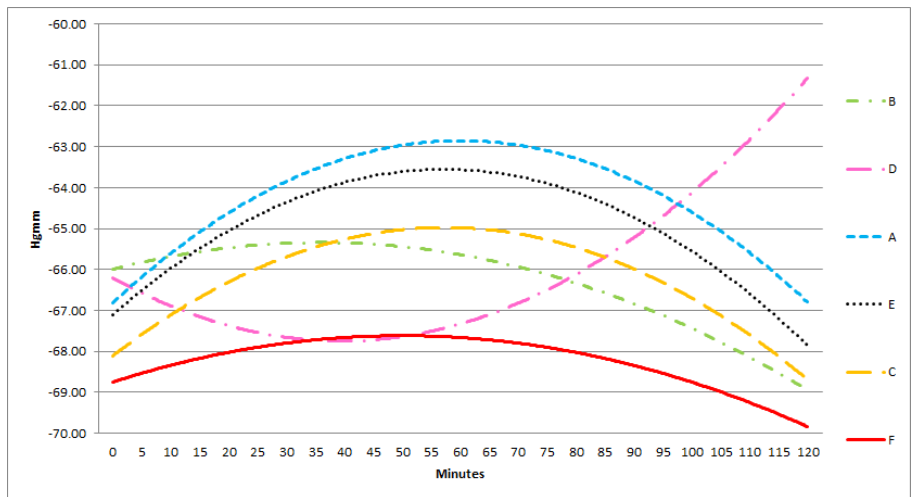
Figure 8. Results of statistical (correlation) analysis between the different sensor pairs during NPWT applying at 150 mmHg suction. The pressure values and their changes in time was measured by different sensors at 150 mmHg NPWT. Sensors represent exact measurement points in the abdominal cavity. (The pressures at sensors A–F are presented enlarged also. A: midline, above the layer; B: midline, under the layer; C: laterally, above the layer; D: laterally, under the layer; E: midline, among the bowels; F: laterally, among the bowels.)